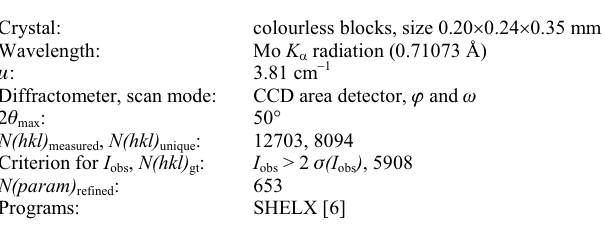
Table 1. Data collection and